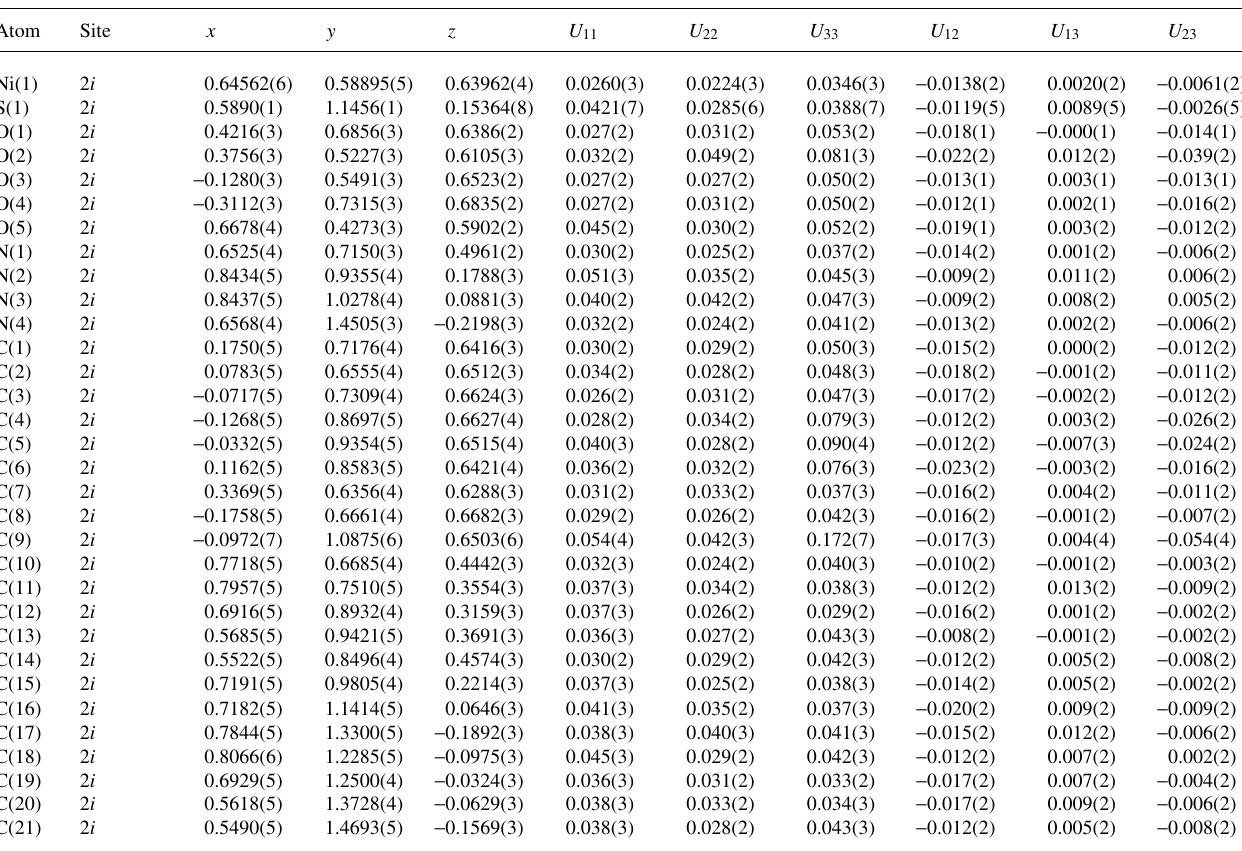
Table 3. Atomic coordinates and displacement parameters (in Å 2 ) .